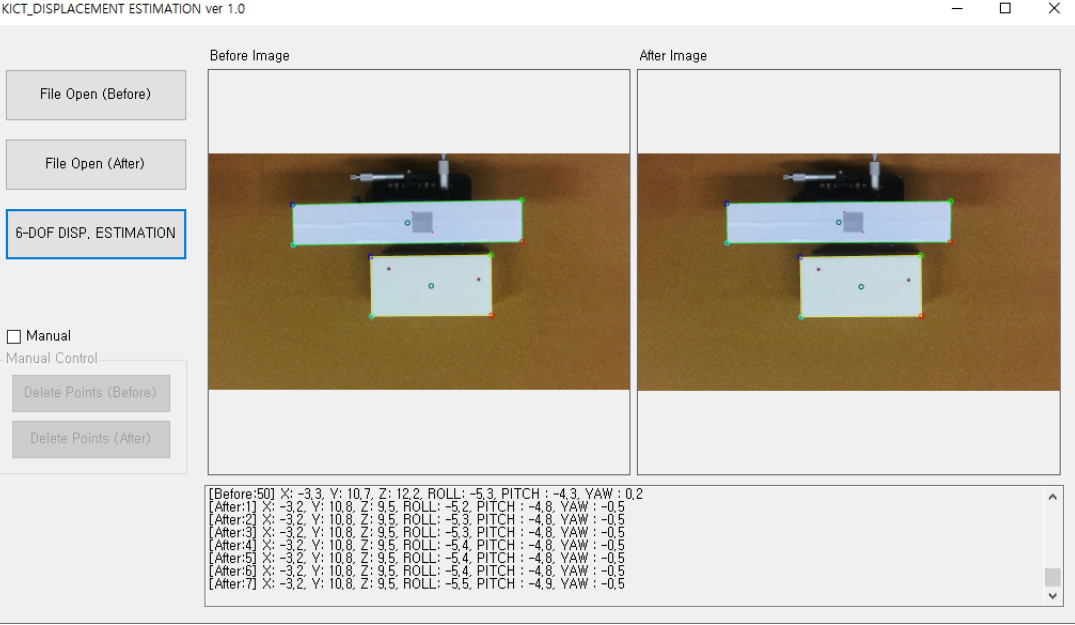
Figure 6. Experimental setup ( a ) port facilities for displacement measurement; ( b ) model structures and the motion stage. Table 2. Root mean square error (RMSE) of 6-DOF displacement estimation.